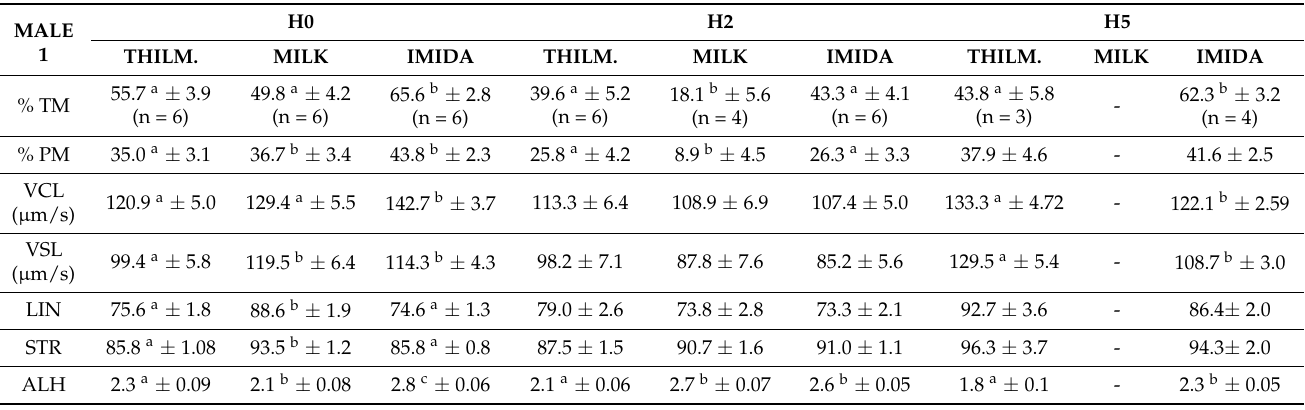
Table 6. Average semen parameters obtained by CASA system for male 1 in the resistance test, according to extender (if there is no number: no motile spermatozoa reached that evaluation time with that extender).